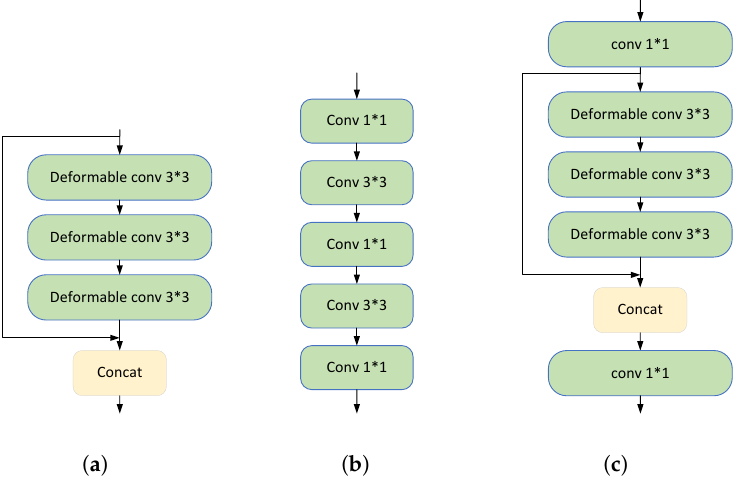
Figure 6. Comparison of original conv module and CRD module: ( a ) res-dcn; ( b ) original conv module; ( c ) CRD